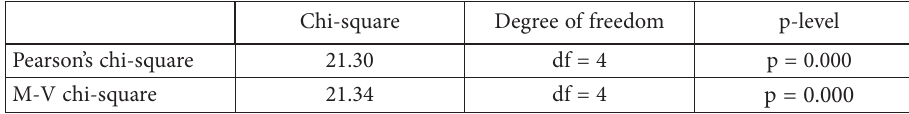
Table 6. χ 2 test for motivational factor base salary from the point of view of gender Chi-square Degree of freedom p-level Pearson’s chi-square 21.30